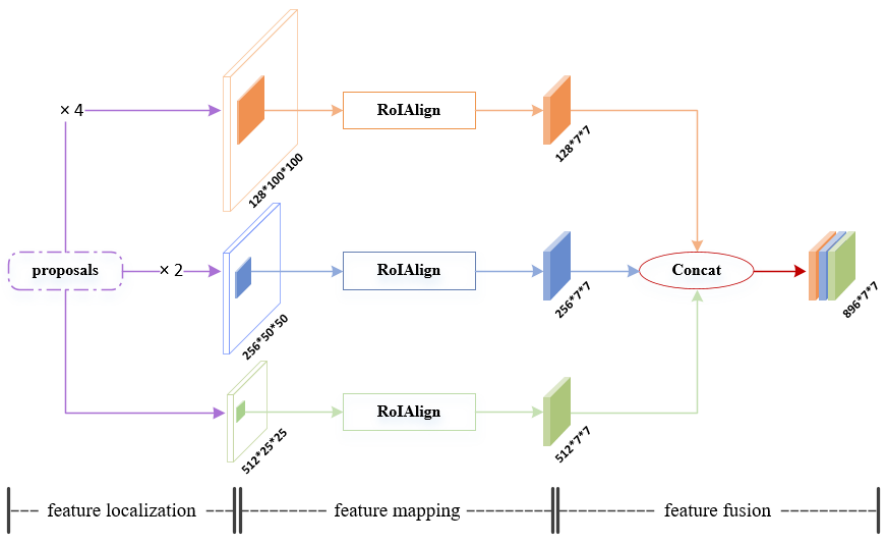
Figure 13. The internal structure of